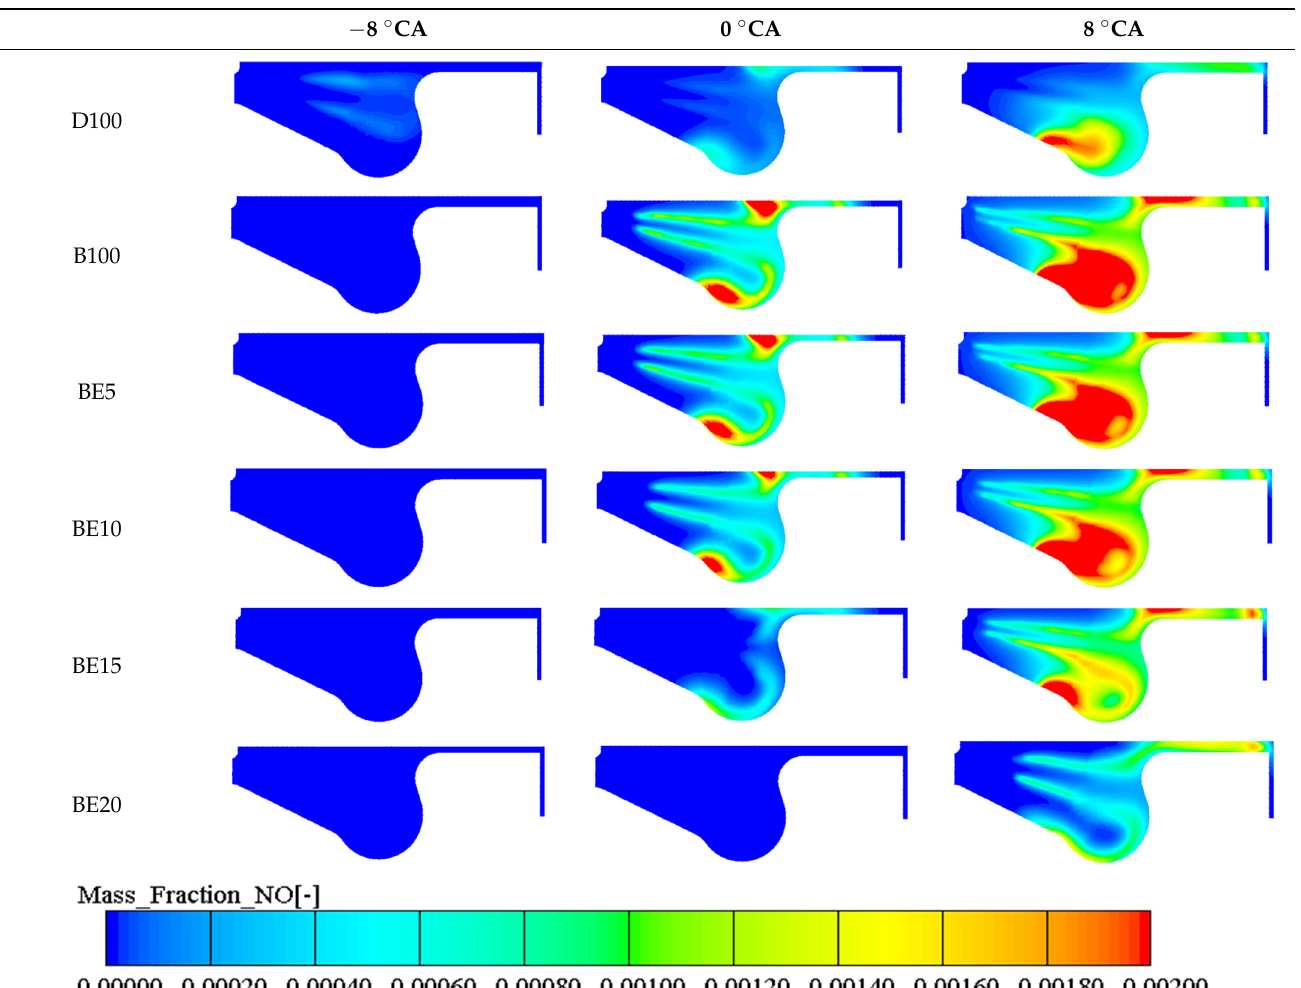
Figure 15. Comparison of CO emission for different blended fuels at different loads. 3.3.3. Soot Emission